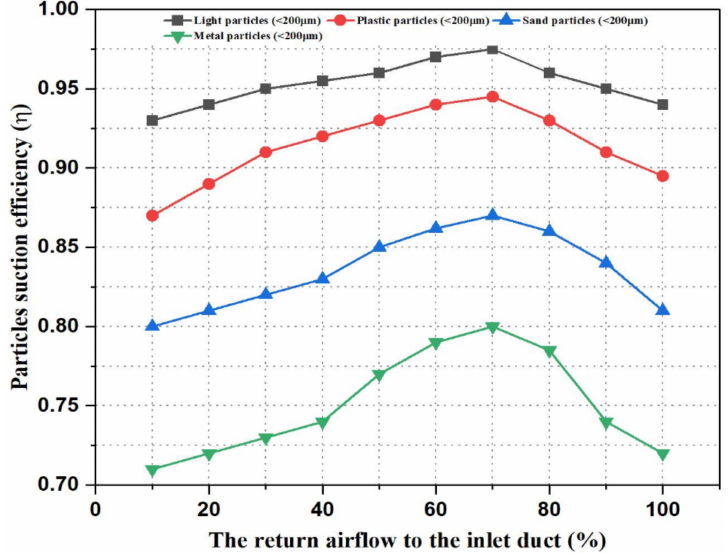
Figure 15. Effect of the amount of flow that is returned to the system on the efficiency of suction.